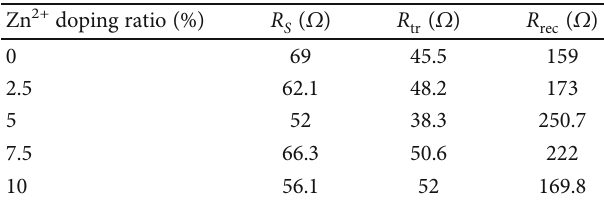
Table 2: EIS parameters of Zn-SnO di ff erent Zn 2+ doping